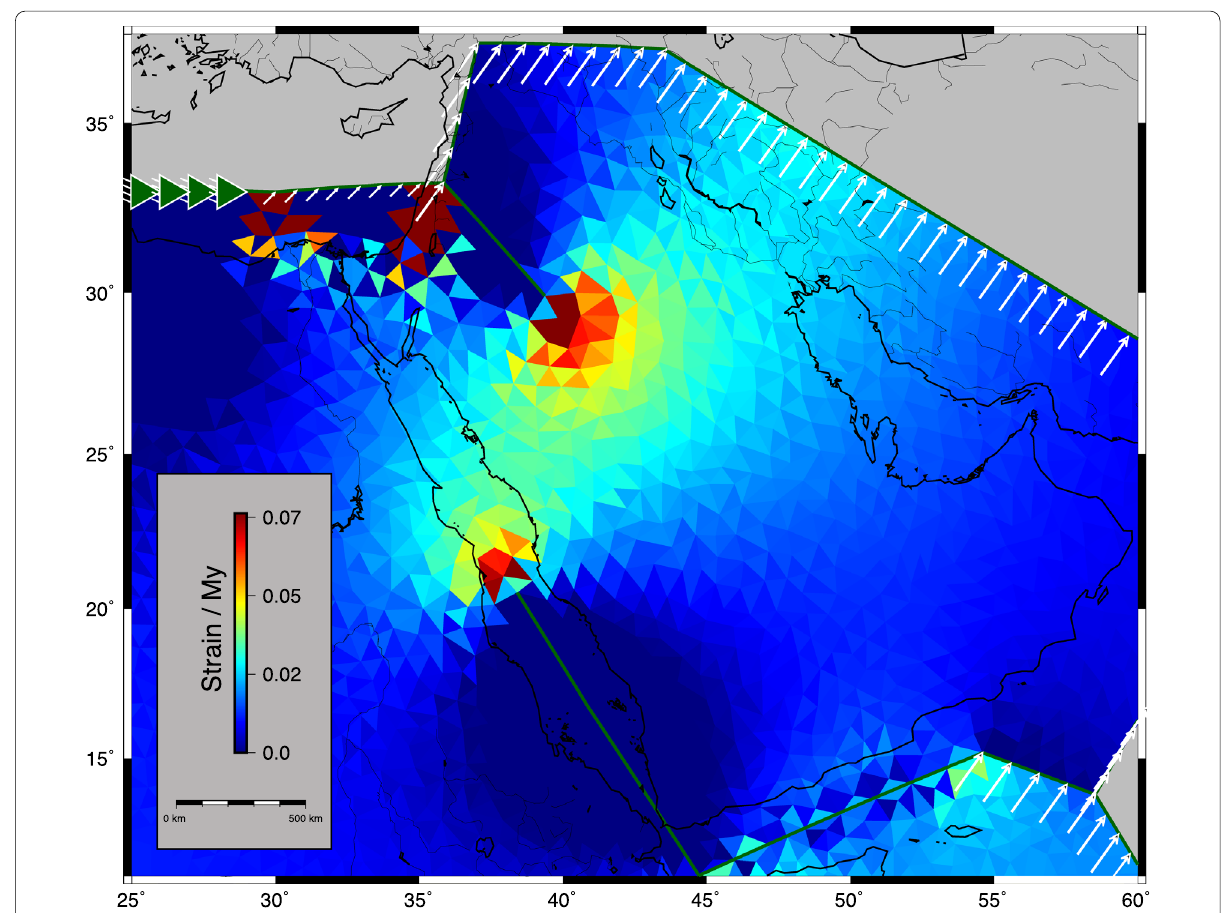
Fig. 4 Strain rate map of the Arabian margin around 30–28 Ma. The dilatational strain rate localizes along a transform zone that produced by the differential motion between the SRS and the Sirhan rifts. We hypothesize that this strain rate pattern was driven by the slowing along the northern boundary, which caused by the onset of Aegean rift due to the Nubian slab roll-back, and passive rifting along the RS and the Sirhan. Along our defined slippery nodes the strain is very low as the displacement occurred mainly along the faults. We using oversimplified rheology as we intend here to highlight a first order process as a function of the given regional boundary conditions, where the region of interest is either covered by volcanic lavas or sand dunes. Although the strain rate pattern covers the whole region between the SRS and Sirhan rift, the volcanic eruptions are observed only in the southern segment of the